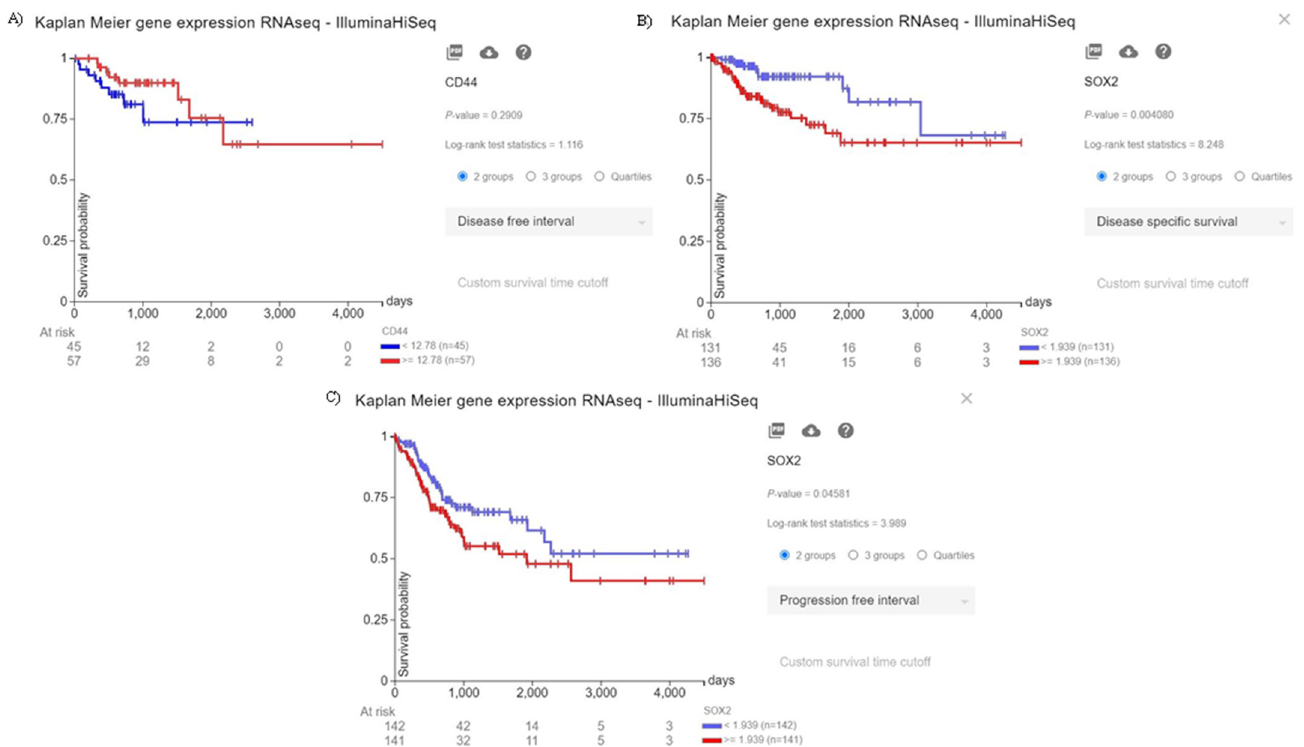
Figure 1. The prognostic value of CD44 and SOX2. ( A ) Although there is a trend between the increased expression of CD44 and the inferior disease-free interval of CRC patients, this trend is not statistically significant ( p = 0.2909). ( B ) The increased expression of SOX2 is significantly associated with the poor disease-specific survival of CRC patients ( p = 0.004080). ( C ) The increased expression of SOX2 is significantly associated with worsened progression-free interval of CRC patients ( p = 0.04581).